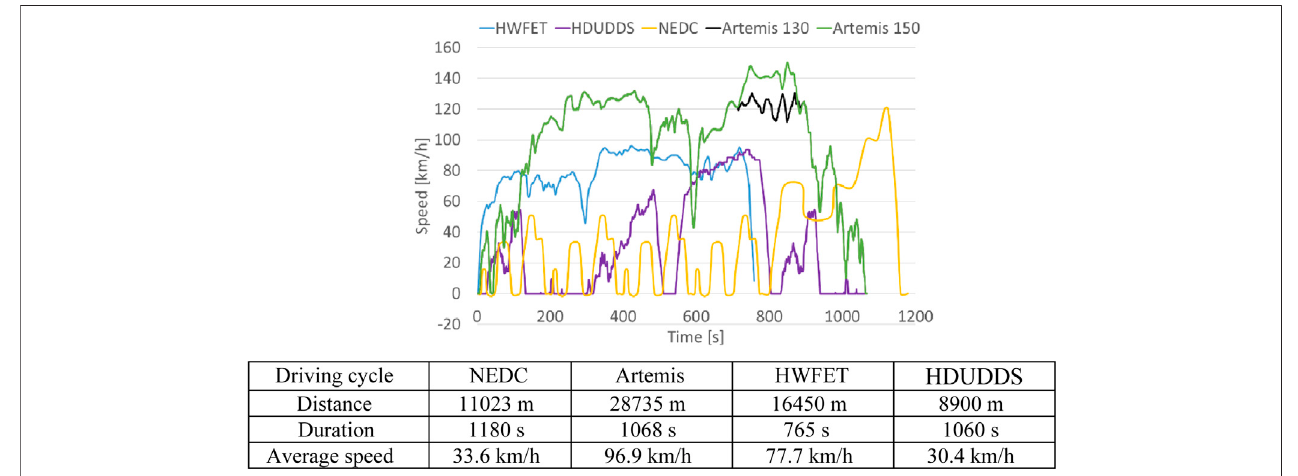
FIGURE 3 | Velocity pro fi les over time for the drive cycles employed in this study with tabulated principal speci fi cations for the drive cycles employed in this study, below.